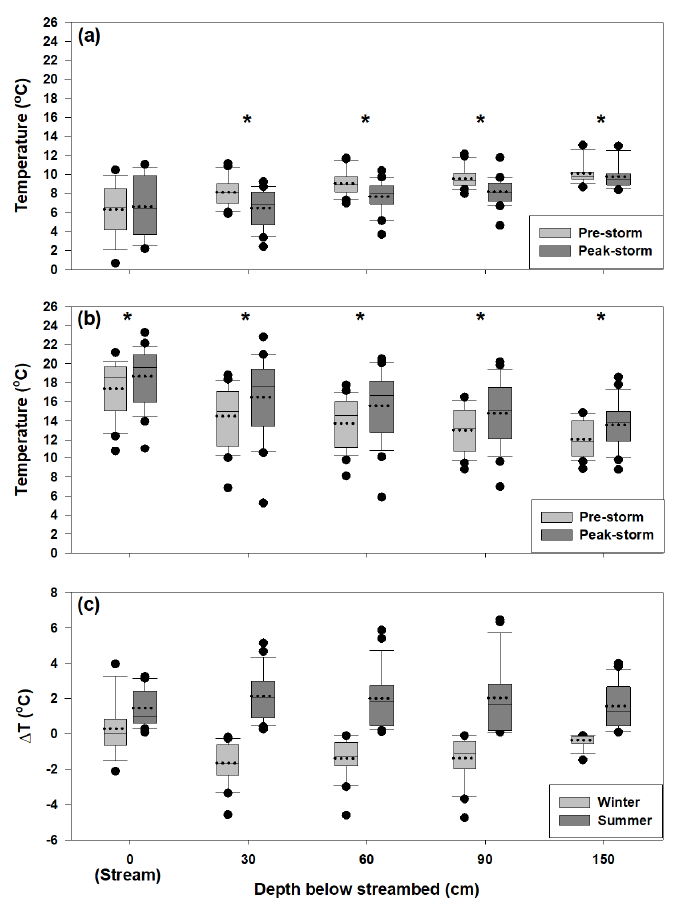
Figure 3. Box plots of pre- and peak-storm temperatures for stream and average of substrate depths for all multi-level samplers: ( a ) Cold periods, ( b ) warm periods and ( c ) post-storm thermal change (ΔT) at substrate depths for all multi-level samplers. The box represents the middle 50% of the data (interquartile range). The lower and upper edges of the box represent the 25th and 75th percentiles, respectively. The solid line represents the median, and the dotted line is the mean. The upper and lower whiskers represent the 10th and 90th percentiles. The points represent outliers. The asterisks (*) in ( a , b ) indicate statistically significant difference between pre- and post- storm temperatures.